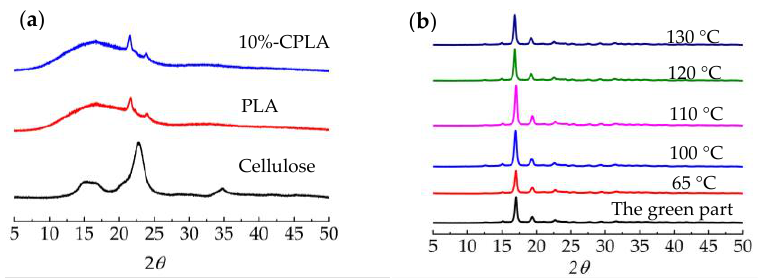
Figure 9. XRD curves of feedstock and laser-sintered 10%-CPLA parts: ( a ) XRD curves of cellulose, PLA 3001D, and 10%-CPLA mixture; ( b ) XRD curves of laser-sintered 10%-CPLA parts.